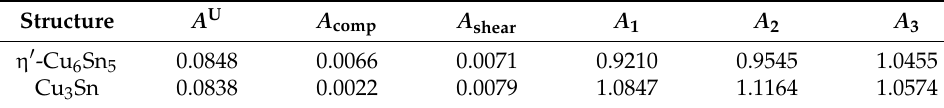
Table 5. The anisotropic indexes of η (cid:48) -Cu 6 Sn 5 and Cu 3 Sn.